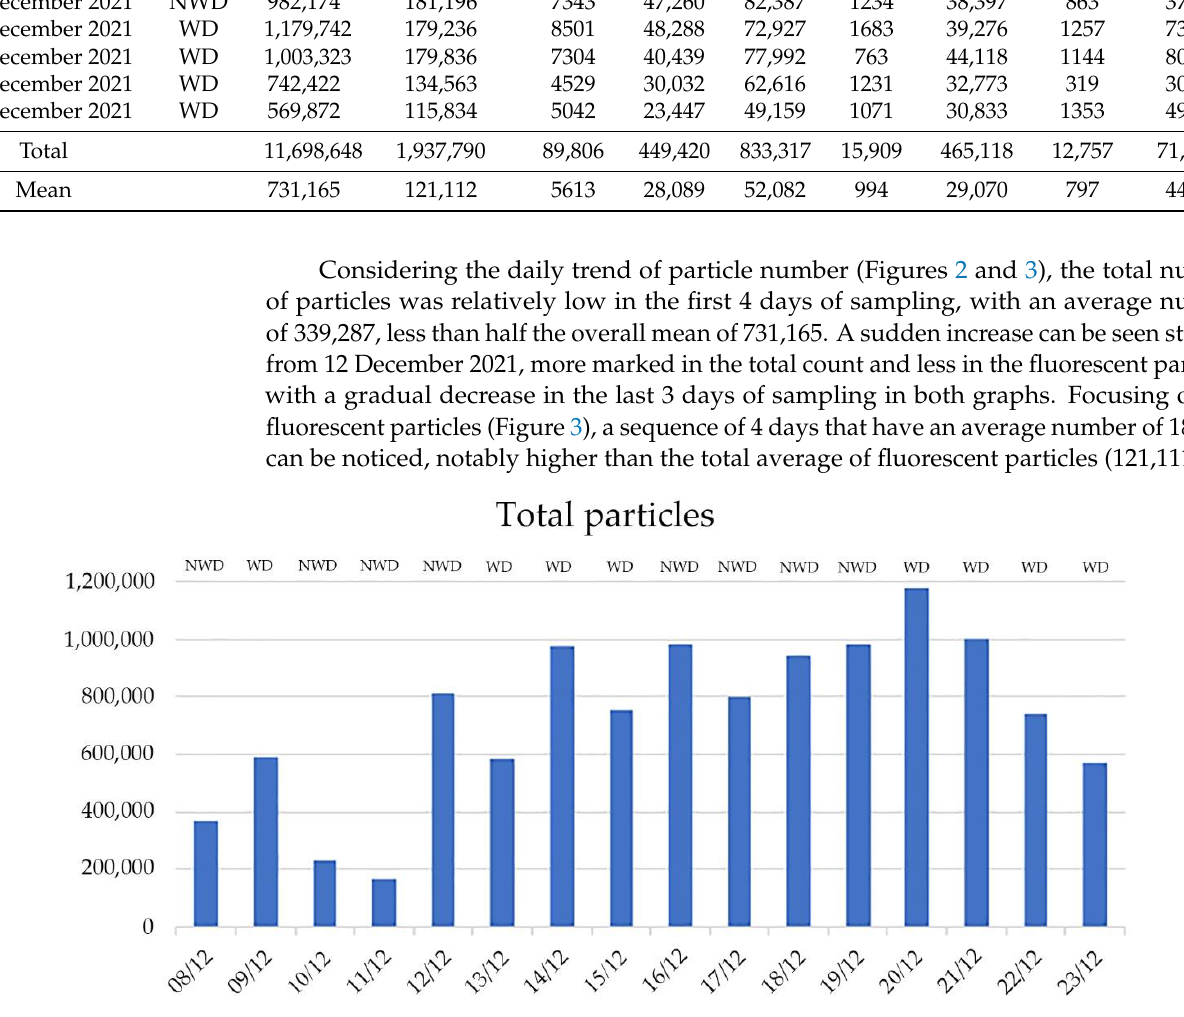
Figure 3. Number of fluorescent particles belonging to different channels (y-axis) for each day of sampling (x-axis). The channels with the lowest number of particles are AB and AC, with a daily aver- age of 994 and 797 respectively. Medium/low number of particles are also related to the A and ABC, with averages of 5612 and 4466. Larger amounts of particles belong to channels B, BC and especially C, with 28,089 and 29,070 and 52,082 average daily particles, respec- tively. The same trends are also shown in the daily percentages of channels contribution (Figure 4), with most of the channels being relatively stable, the most variable being BC and ABC.